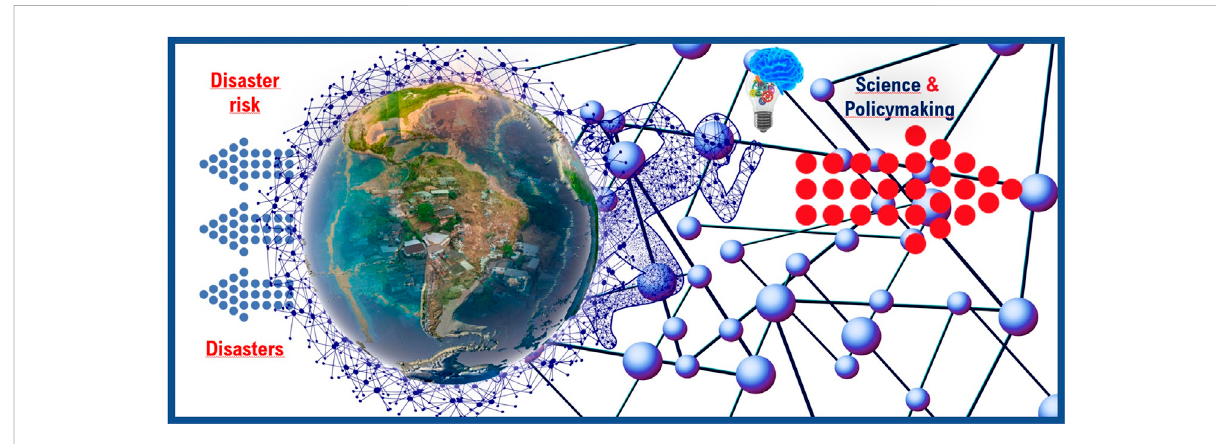
FIGURE 1 A basic interaction scheme between disaster risk and disasters and the need to promote science-based